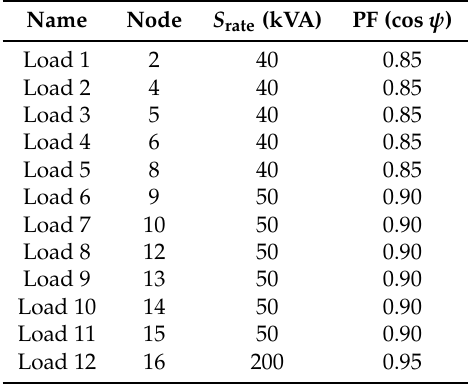
Table 1. Parameters of loads of the microgrid.